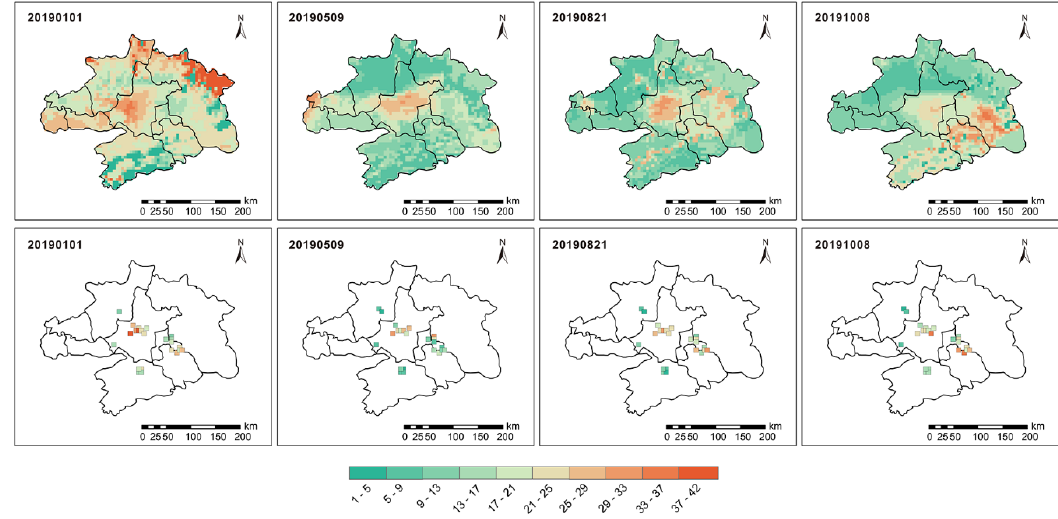
Figure 6. Mapping results of ground NO 2 concentrations. The top row is remote sensing retrievals of NO 2 concentrations, and the bottom row is station measurements.